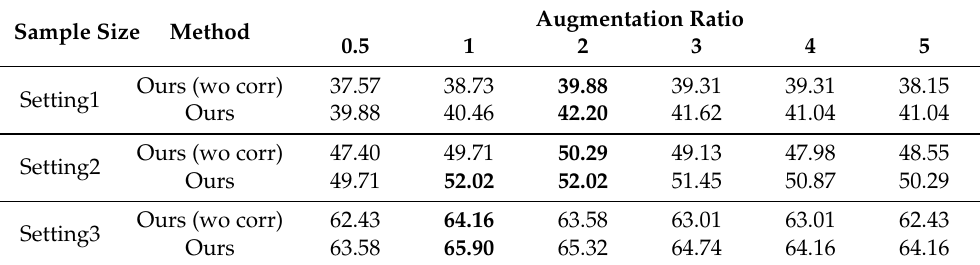
Figure 6. Training loss of different methods on the datasets of eNTERFACE’05, RAVDESS, and CMEW. ( a ) Baseline (A+V), ( b ) Ours (wo corr), ( c ) Ours. Table 5. Classification accuracy (%) with different augmentation ratios on the RAVDESS dataset. Best results are shown in bold.